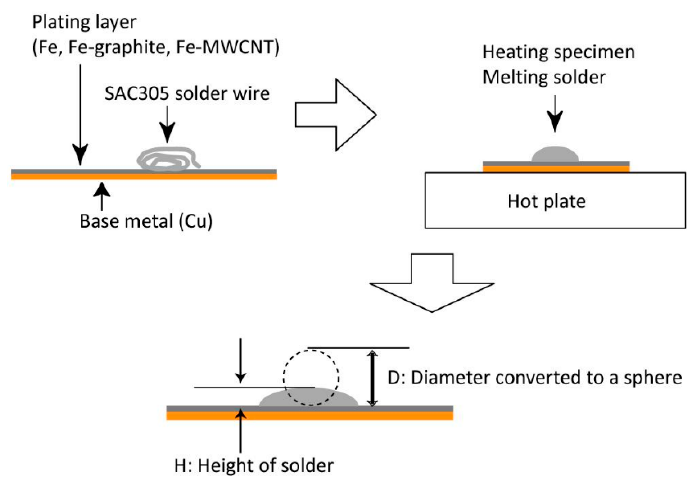
Figure 2. Solder spread test method.